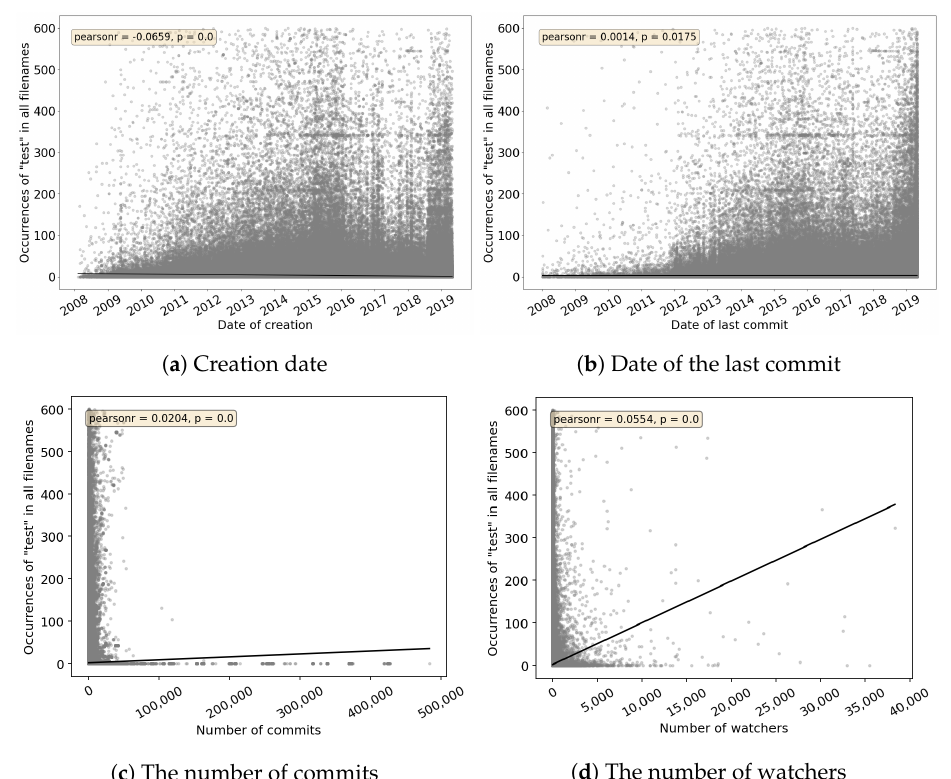
Figure A4. Correlation between the number of occurrences of the word “test” in all files filename and project’s life cycle parameters.